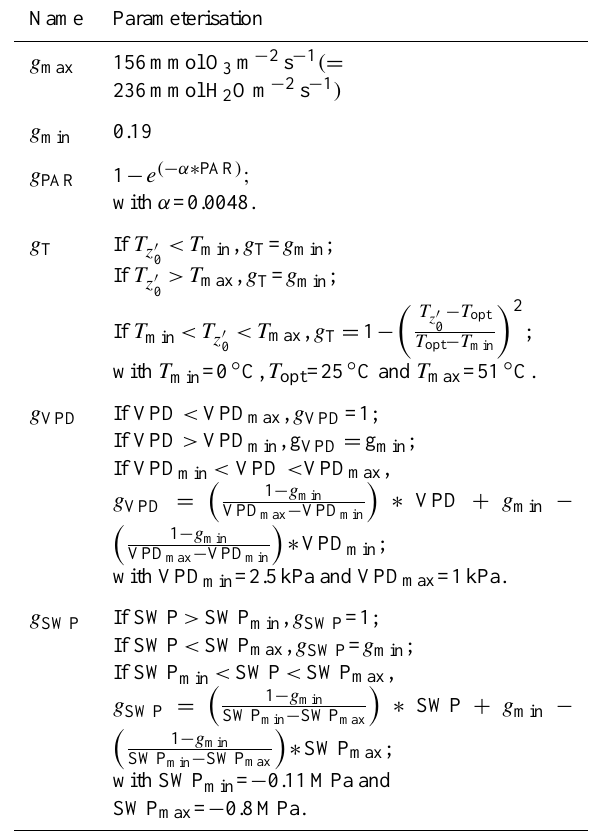
Table 1. Parameterisations used in the stomatal resistance model. PAR is the photosynthetically active radiation (µmolm − 2 s − 1 ) , VPD is the leaf vapour pressure deficit (kPa), T z 0 ature ( ◦ C), and SWP is the soil water deficit